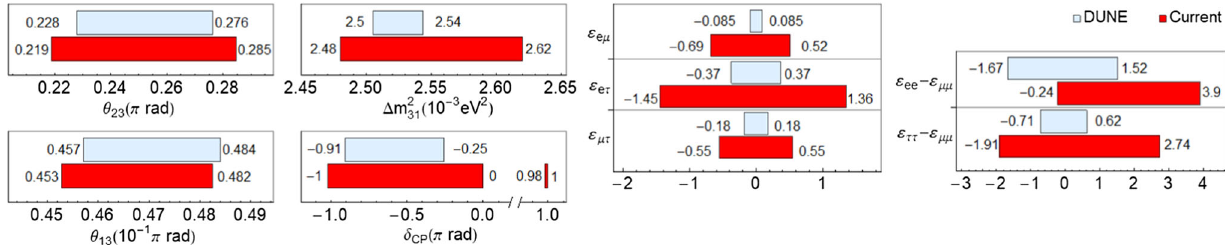
tom of each comparison. The five comparisons in the right half show constraints on non-standard interaction